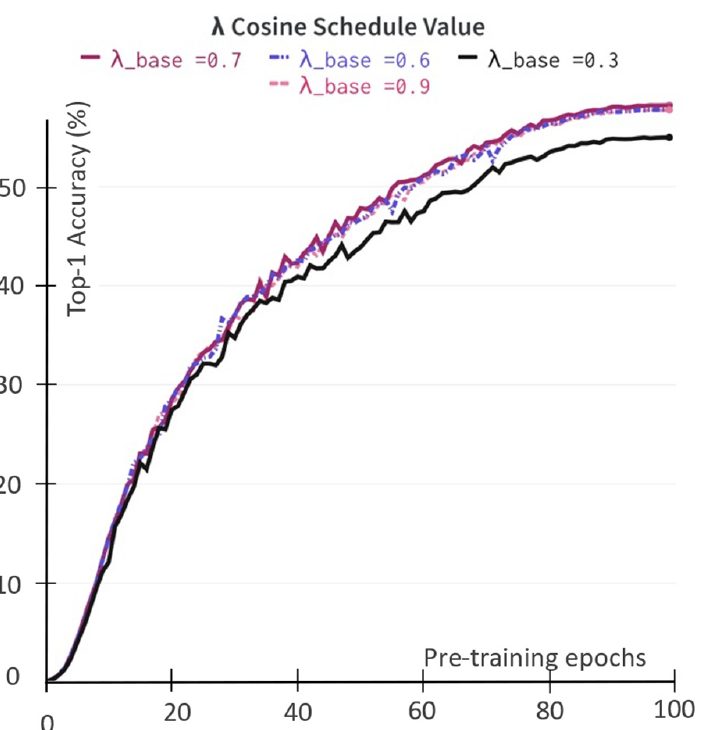
Figure 5. The impact of the weighting coefficient λ value to the obtained representation of the pre-trained encoder (ResNet-50) during the self-supervised pretraining stage on the ImageNet linear evaluation protocol in Top-1 accuracy (in %).